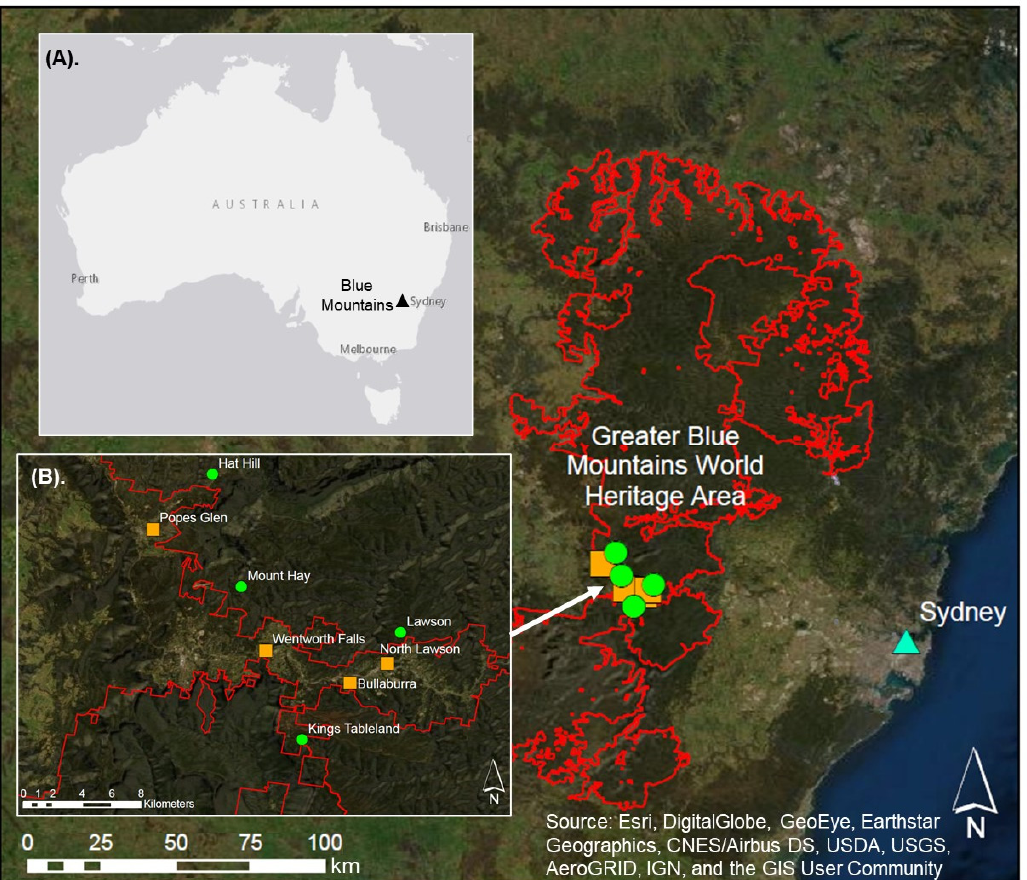
Figure 1. The location of the study region in the Blue Mountains (inset ( A )), west of Sydney (blue triangle), NSW, Australia, with the boundary of the Greater Blue Mountains World Heritage Area shown in red [46]; Creative Commons Attribution 4.0]. Inset ( B ) outlines the Temperate Highland Peat Swamps on Sandstone (THPSS) sites, including urban (orange squares) and naturally vegetated (green circles) THPSS catchments.